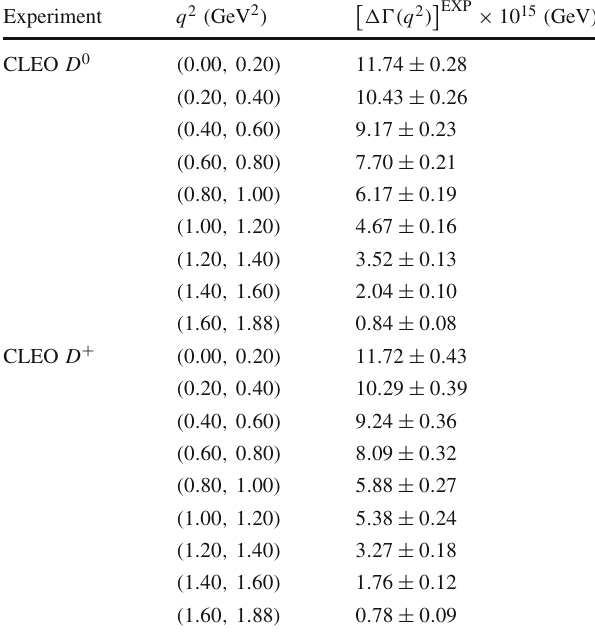
(cid:10) (cid:11) EXP for the D → π (cid:6)(cid:5)( q 2 ) (cid:10) (cid:11) EXP × 10 16 ( GeV ) (cid:6)(cid:5)( q 2 )